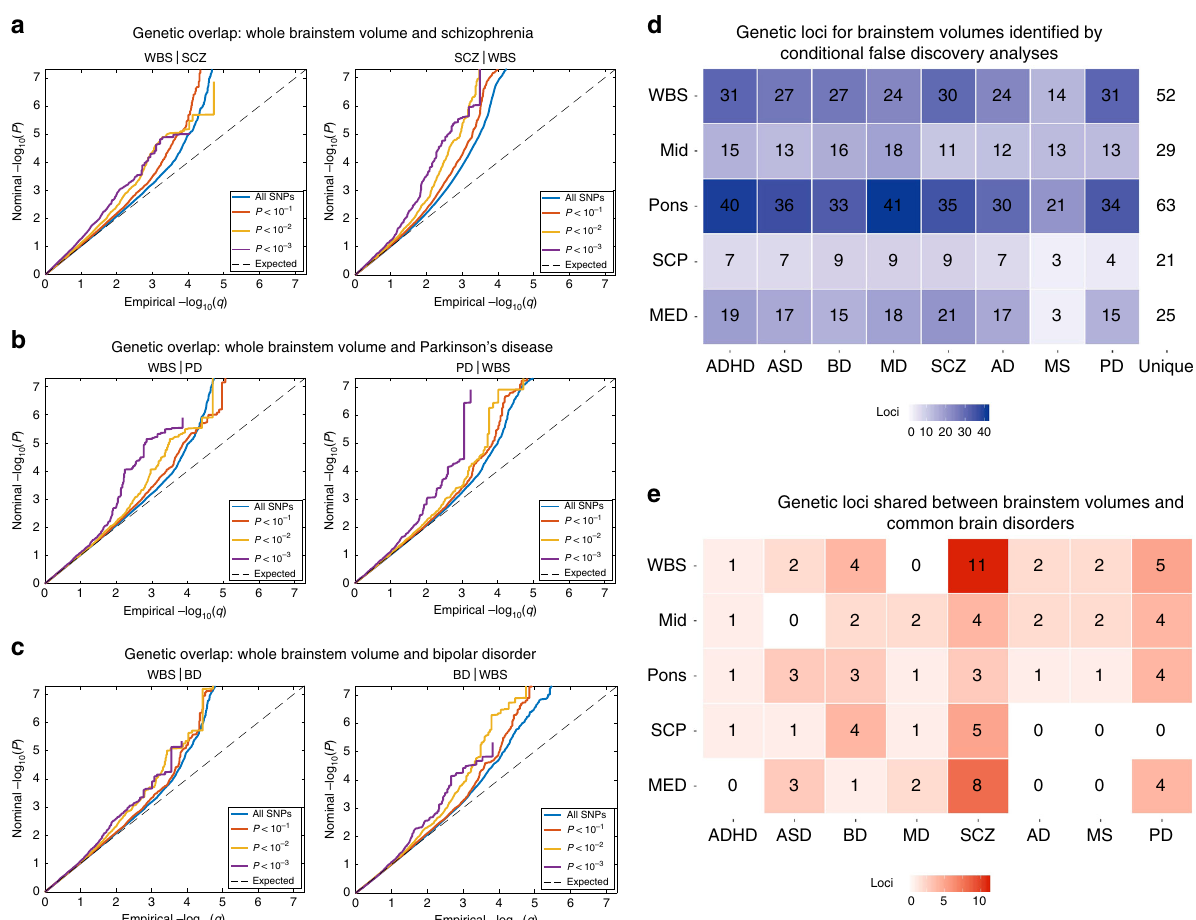
Fig. 3 Genetic overlap between brainstem volumes and common brain disorders. a Conditional Q – Q plots for whole brainstem volume conditioned on SCZ (left) and vice versa (right), demonstrating genetic overlap. b Conditional Q – Q plots for whole brainstem volume conditioned on PD (left) and vice versa (right), showing genetic overlap between these phenotypes. c Conditional Q – Q plots for whole brainstem volume conditioned on BD (left) and vice versa (right), demonstrating genetic overlap. d Enhanced discovery of genetic loci for each of the brainstem volumes when conditional false discovery rate analyses were run for each of the brainstem volumes conditioned on the eight brain disorders. These analyses revealed a total of 208 genetic loci for whole brainstem volume, and 111, 270, 55, and 125 loci for volumes of the midbrain, pons, SCP, and medulla oblongata, respectively. These genetic regions were located in 52 unique genetic loci for whole brainstem volume, and 29, 63, 21, and 25 unique loci for volumes of the midbrain, pons, SCP, and medulla oblongata. e conjunctional false discovery rate analysis detected shared genetic loci across brainstem volumes and the eight clinical conditions. The largest numbers of shared loci were found for SCZ (31), BD (14), and PD (17), whereas 8, 4, 6, 9, and 5 genetic loci were jointly shared for ASD, ADHD, MD, AD, and MS, respectively, and the brainstem volumes, when applying a conjunctional FDR threshold of 0.05. WBS whole brainstem. MID midbrain. SCP superior cerebellar peduncle. MED medulla oblongata. ADHD attention-de fi cit/hyperactivity disorder. ASD autism spectrum disorders. BD bipolar disorder. MD major depression. SCZ schizophrenia. AD Alzheimer ’ s disease. MS multiple sclerosis. PD Parkinson ’ s